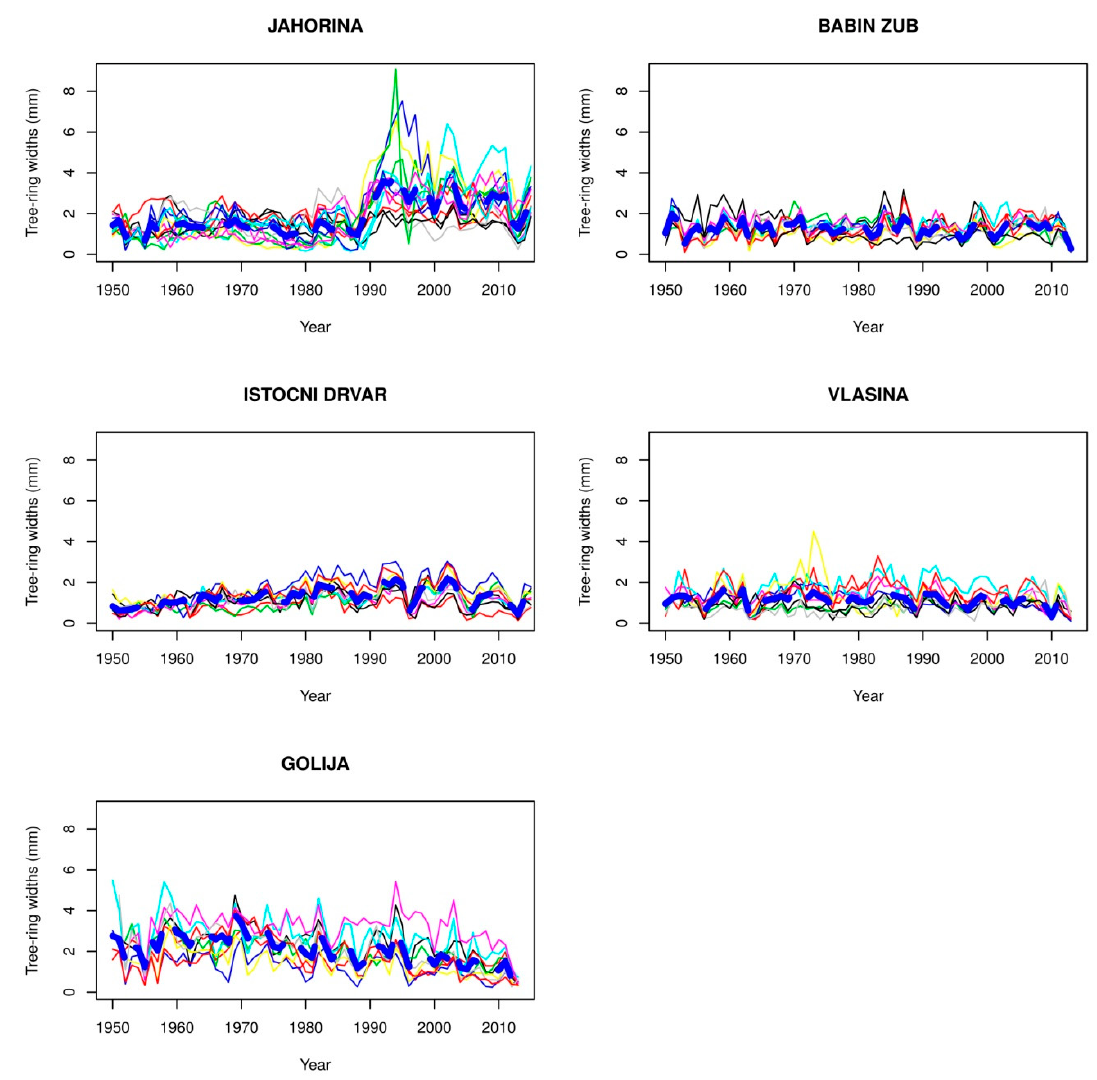
Figure 4. Chronology of beech trees at the upper limit of their vertical distribution.